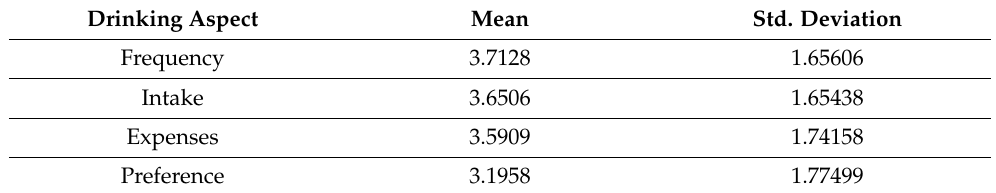
Table 4. Descriptive analysis results of perceived changes in drinking aspects.